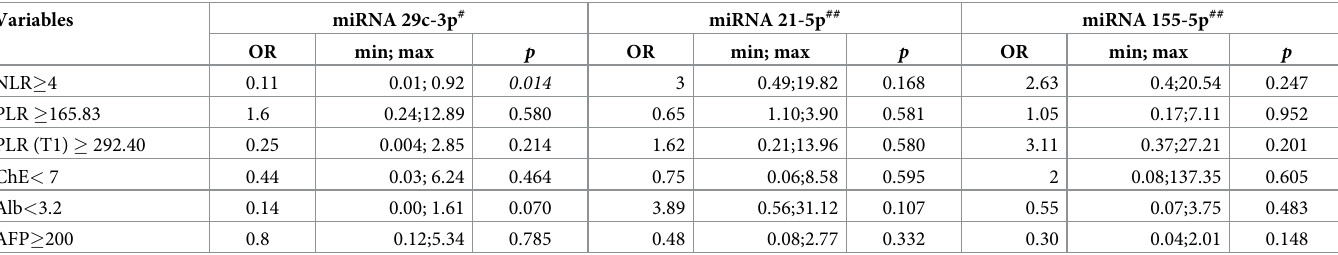
Table 5. The odds ratio analyses of up-regulation miRNA based on cut off value clinical variables in 27 HCC patients.